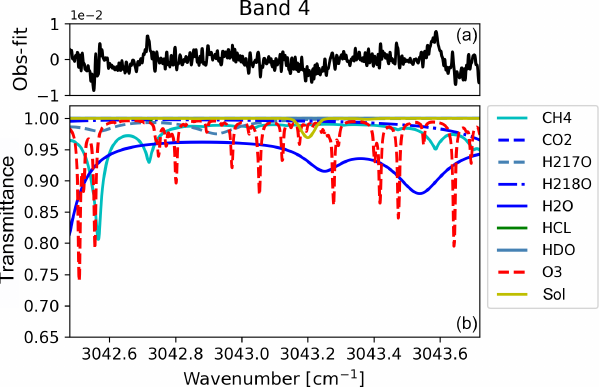
Figure A1. An example of spectral fit in the microwindow between 3042.48 and 3043.72cm − 1 using the method of García et al. (2014) at Xianghe. It is the same spectrum shown in Fig. 1. (b) The normal- ized transmittance from each atmospheric species and solar lines. (a) The difference between the observed and fitted spectra (“Obs-